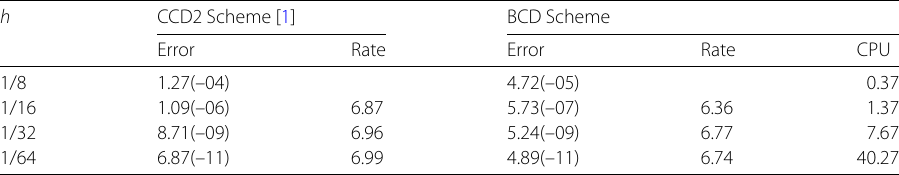
Table 2 The maximum absolute error and convergence rate for Problem 2 with ε = 10 –1 h